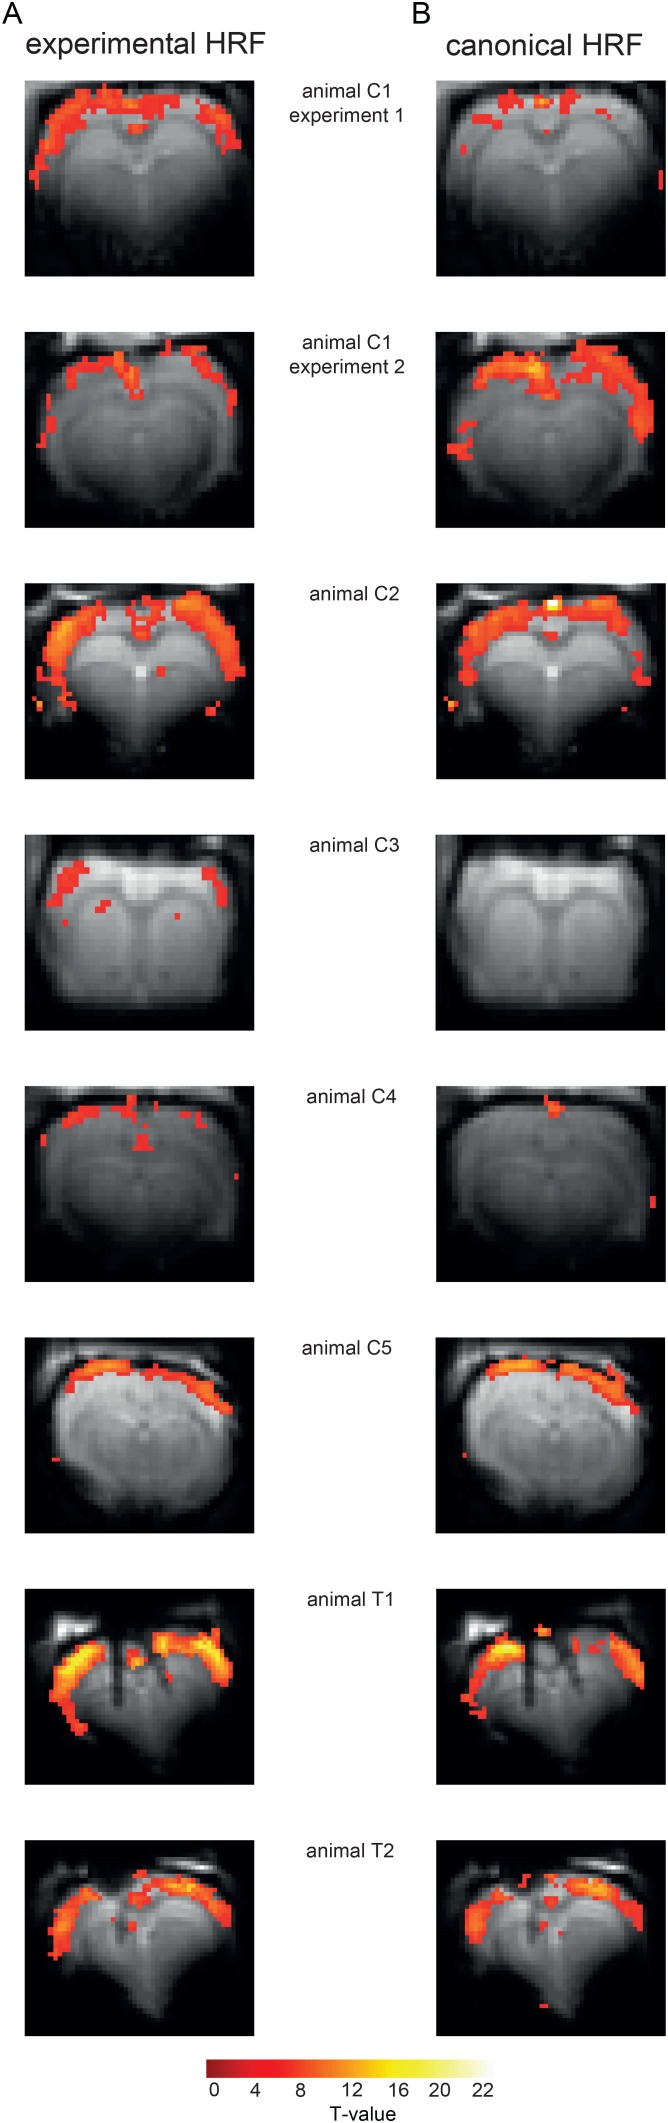
Similar activity patterns upon employing HRFs extracted from datasets based on FIR approach and classical canonical HRF model.All activation maps were scaled to the overall maximum detected T-value (note that this maximum T-value in animal C2 (B) is only achieved because of spurious activity in the sinus vein detected by the canonical HRF approach). (A) Activation maps resulting from FIR-based event-related fMRI analysis of datasets shown in Figure 3, Figure 3—figure supplement 1 and Figure 4. (B) Activation maps resulting from event-related fMRI analysis of the same datasets while using the standard canonical HRF implemented in SPM, which is modelled by two gamma functions.